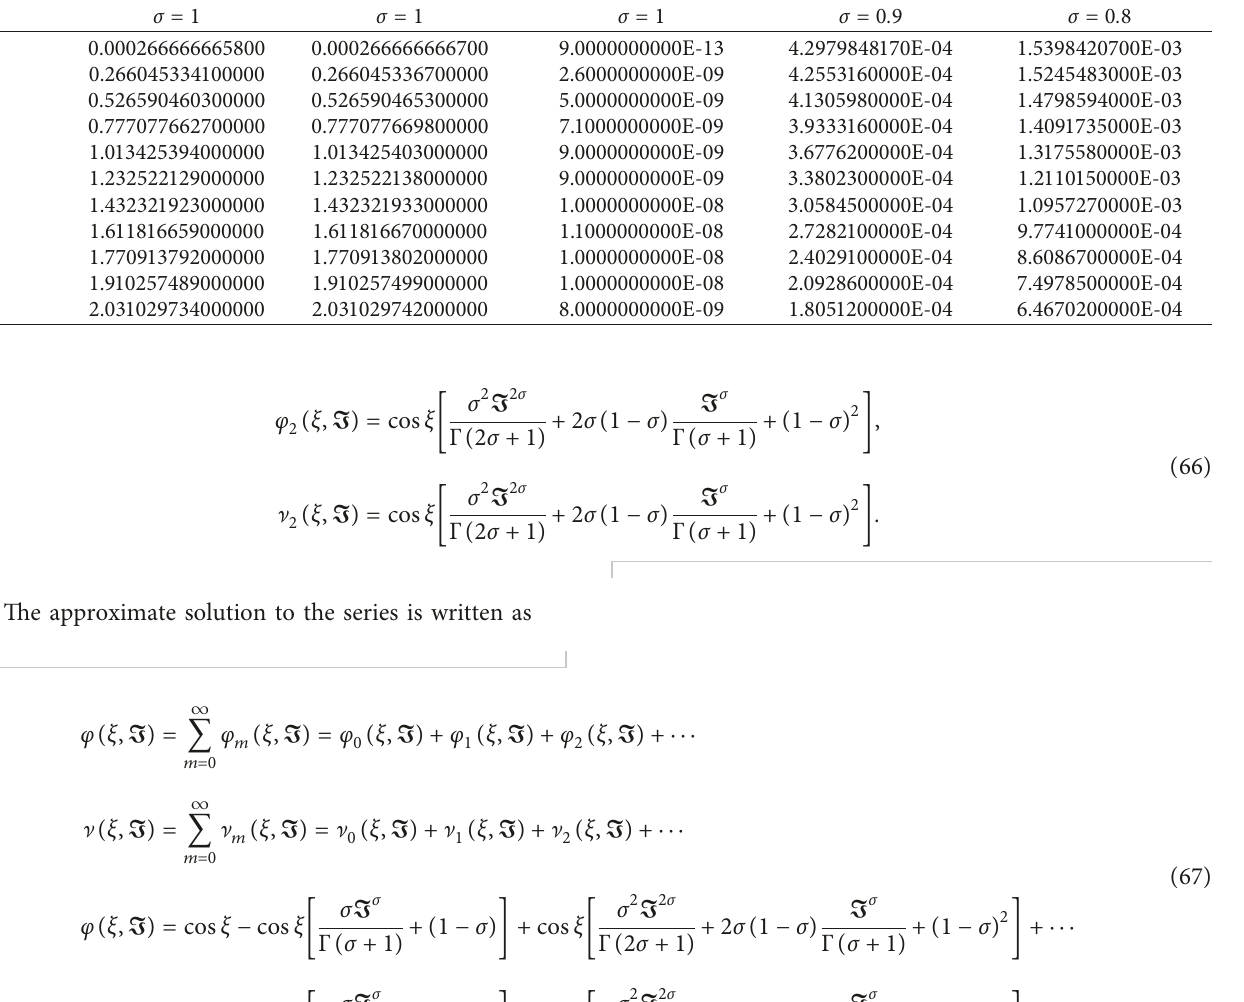
Table 5: Comparison of the proposed method and exact results with absolute error (AE) at various fractional order for ℓ ( ξ , I ) of problem 2. I � 0 .